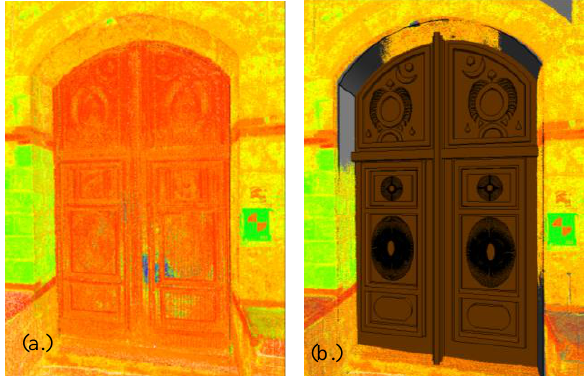
Nasif Historical House. Figure 16. Modelling the main gates of Nasif